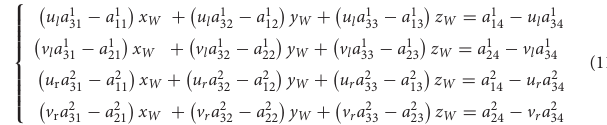
algorithm. The plane (cid:53) l and plane (cid:53) r are the image planes of Camera-1 and Camera-2 before polar correction, and the plane (cid:48) (cid:53) (cid:48) and plane (cid:53) are the image planes of Camera-1 and Camera- r l (cid:48) (cid:48) 2 after polar correction. The p and p are the pixel coordinates of r l (cid:48) (cid:48) point P in the plane (cid:53) and plane (cid:53) . The rotating vector R r l